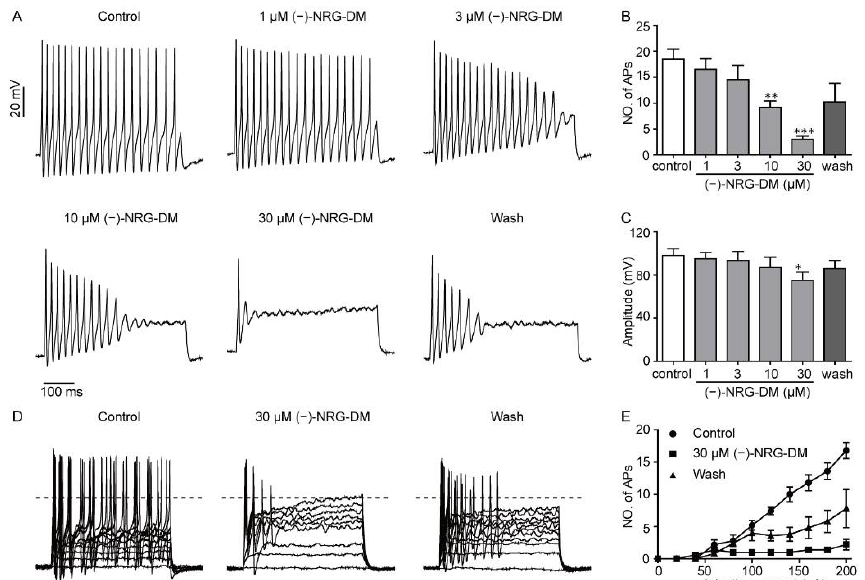
Figure 4. (−)-NRG-DM inhibited the neuronal excitability of acutely isolated mouse dorsal root ganglion neurons. ( A ) Representative traces of action potentials following 200 pA current injection with or without (−)-NRG-DM at indicated concentrations in DRG neurons. Bar graph showing the effects of (−)-NRG-DM on the firing frequency ( B ), amplitudes of the first action potential ( C ) before (control, white) and after the application of (−)-NRG-DM (grey) at indicated concentrations ( n ≥ 5). ( D ) Responses of representative DRG neurons with or without 30 μM (−)-NRG-DM to 500 ms depolarization current steps for the generation of all-or-none action potential. ( E ) The averaged number of action potentials of DRG neurons before and after application of 30 μM (−)-NRG-DM ( n = 5). Statistical significance: * p ≤ 0.05, ** p ≤ 0.01, *** p ≤ 0.001.